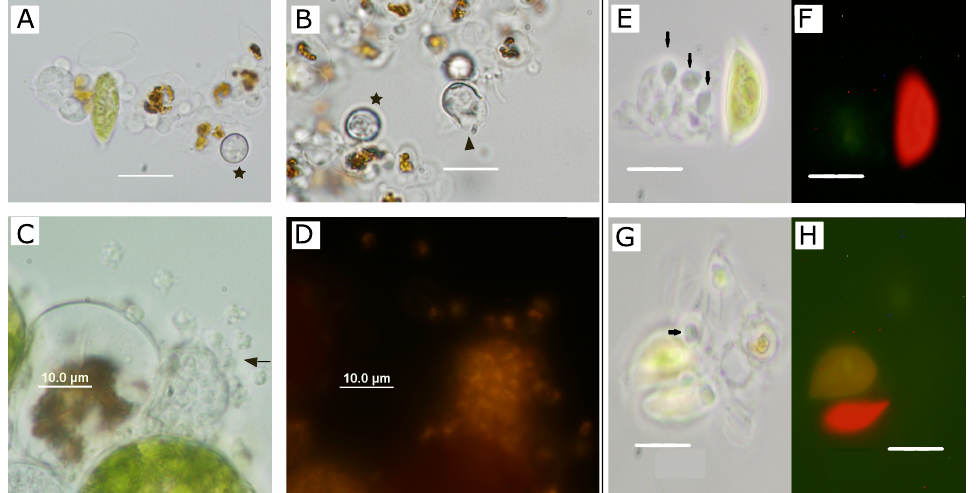
Figure 6. Comparison of S. dimorphus inoculated cultures ( A , B , E – H ) and H. pluvialis propagules release ( C , D ). ( A ) S. dimorphus infected cells carrying P. sedebokerense cysts; thicker cell wall resting cyst is marked by a star, 27 h after inoculation; ( B ) Resting cyst of P. sedebokerense (arrowhead) germinating and liberating the sporangium to media 48 h after inoculation; ( C , D ) vegetative sporangium of P. sedebokerense 27 h after inoculation on H. pluvialis cells releasing amoeboid swarmers